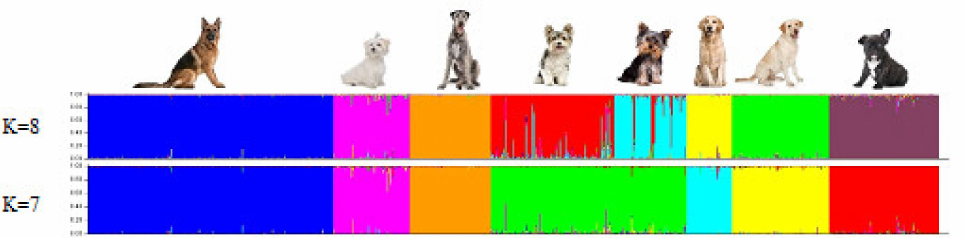
Figure 4. STRUCTURE analysis of 21 STR genotypes from all study dogs (903 samples). The samples were grouped by the eight breeds (K = 8). In the case of K = 7, YT and BYT breeds were grouped in one